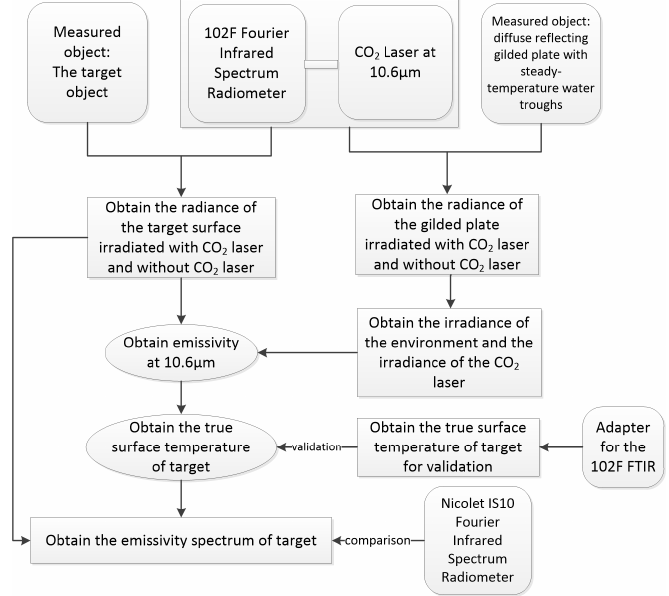
Figure 1. Flowchart of retrieving the emissivity spectrum of the target surface.